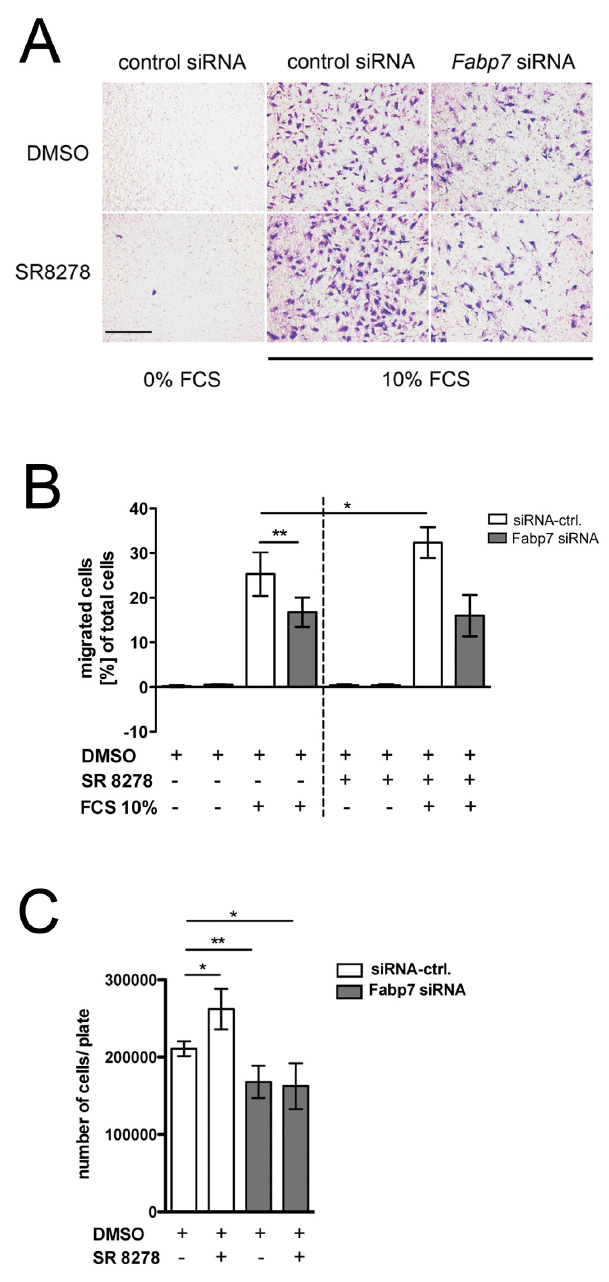
Figure 7. Influence of Rev-erb a and Fabp7 on migration and proliferation of U-251 MG glioblastoma cells. ( A ) Cells were analyzed under non-migrating (0% FCS) and migrating (10% FCS) conditions 6 hours after treatment. The Rev-erb a antagonist SR8278 (10 m M) increased migration of the cells compared to DMSO control. siRNA against Fabp7 (Fabp7 16) reduced this migration. Scale bar: 200 m m. ( B ) Quantification of the experiment in A. Shown is the mean 6 SD for n=3 independent experiments (*p , 0.05, **p , 0.005, t-test). ( C ) Number of cells 72 hours after transfection with either control or Fabp7 siRNA in presence or absence of the Rev-erb a antagonist SR 8278. The mean 6 SD for n=4 experiments (*p , 0.05, **p , 0.01, t-test) is